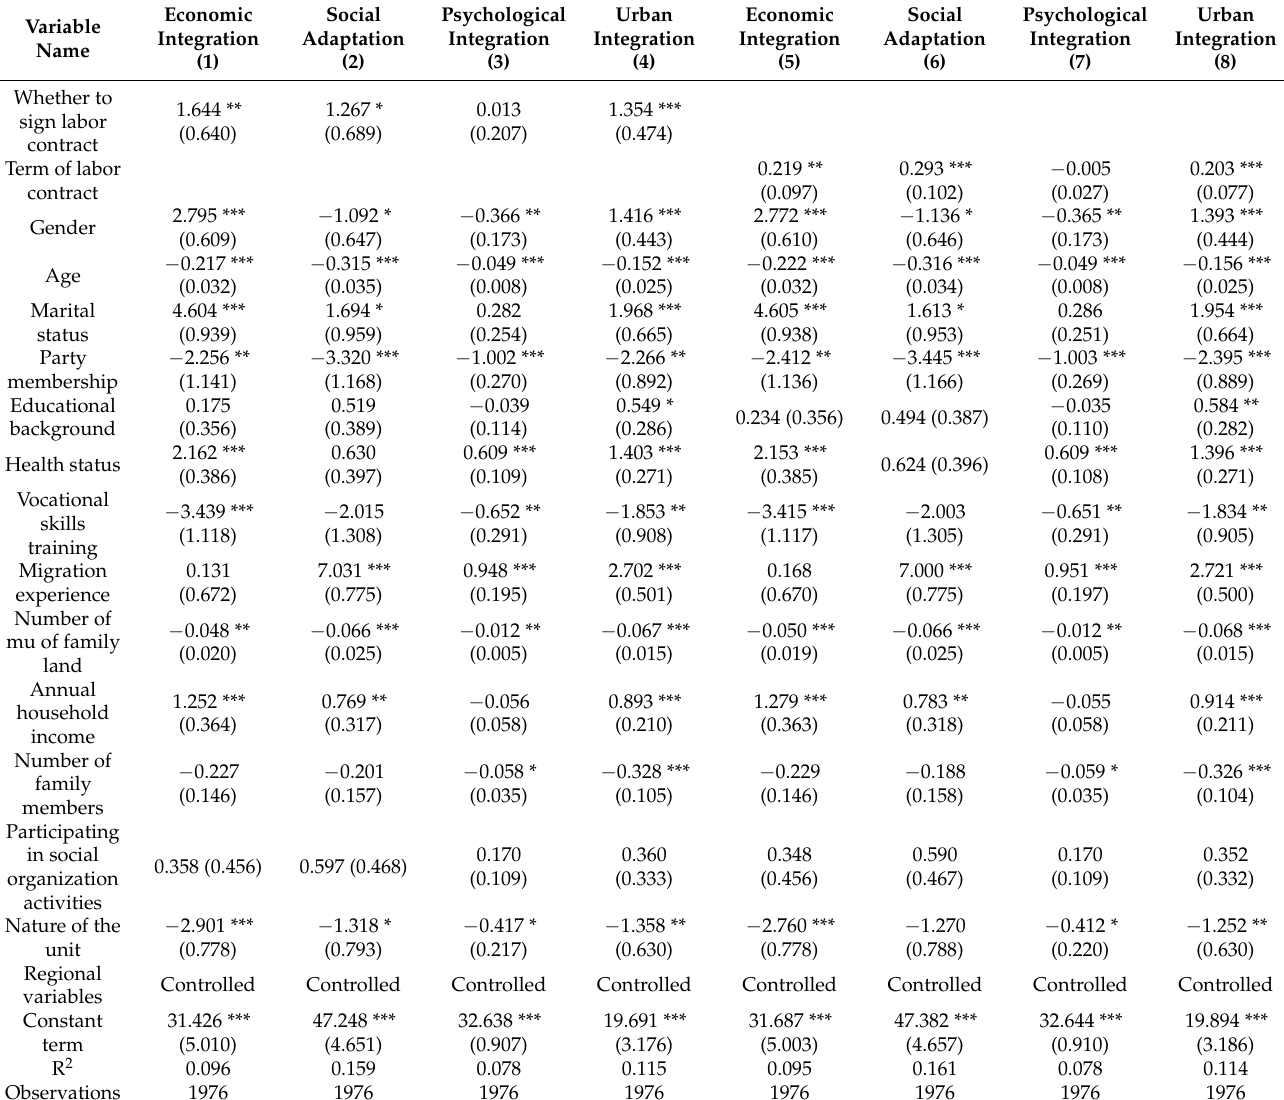
Table 3. Regression results of the impact of labor contract on the urban integration of migrant